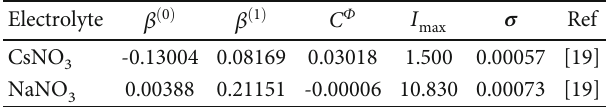
Table 2: Values of the Pitzer parameters for CsNO 298.15K.